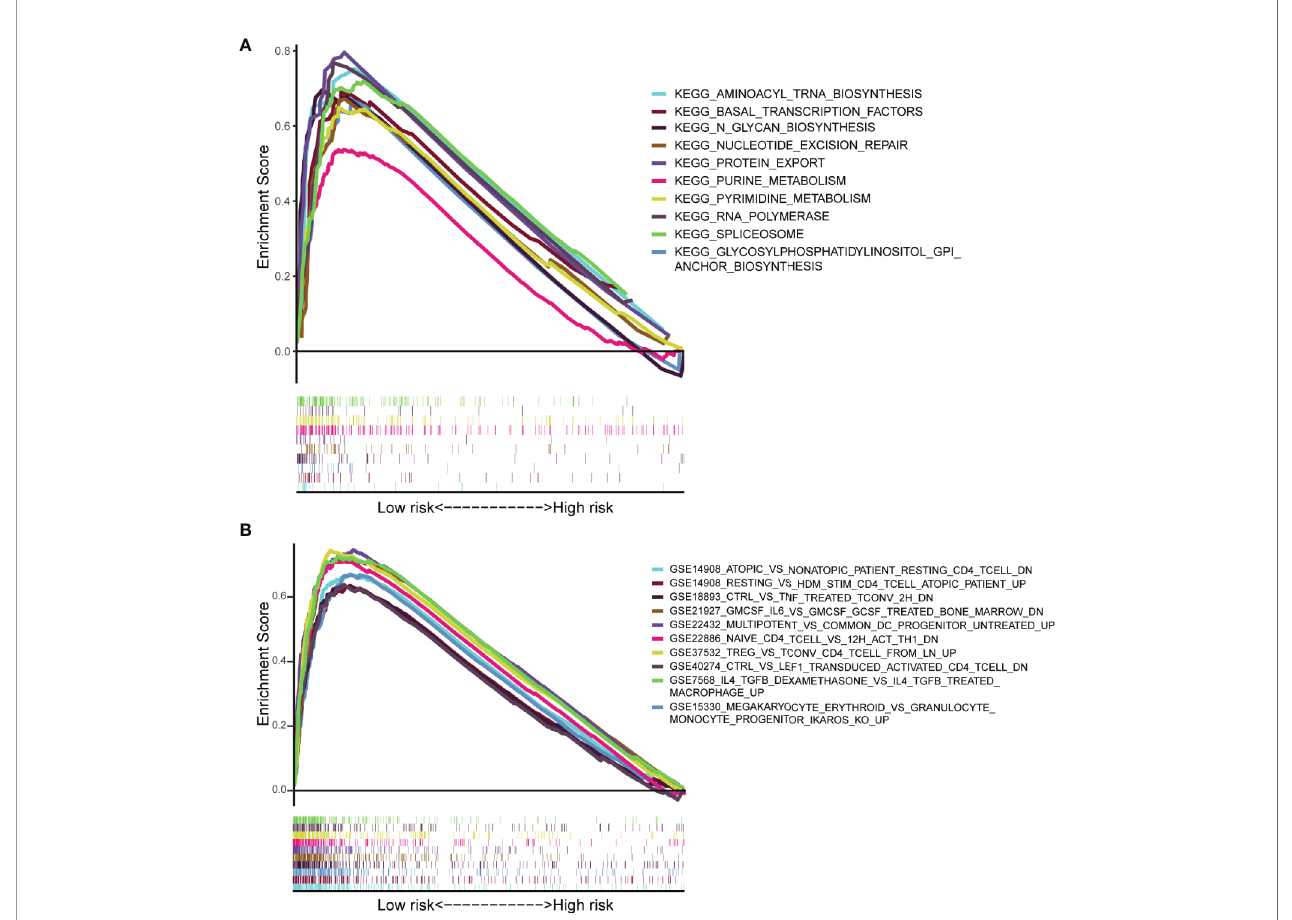
FIGURE 7 | Results of gene set enrichment analysis in the TCGA cohort. (A) The signi fi cantly enriched KEGG subset of canonical pathways by GSEA. (B) The signi fi cantly enriched Immunologic gene sets by